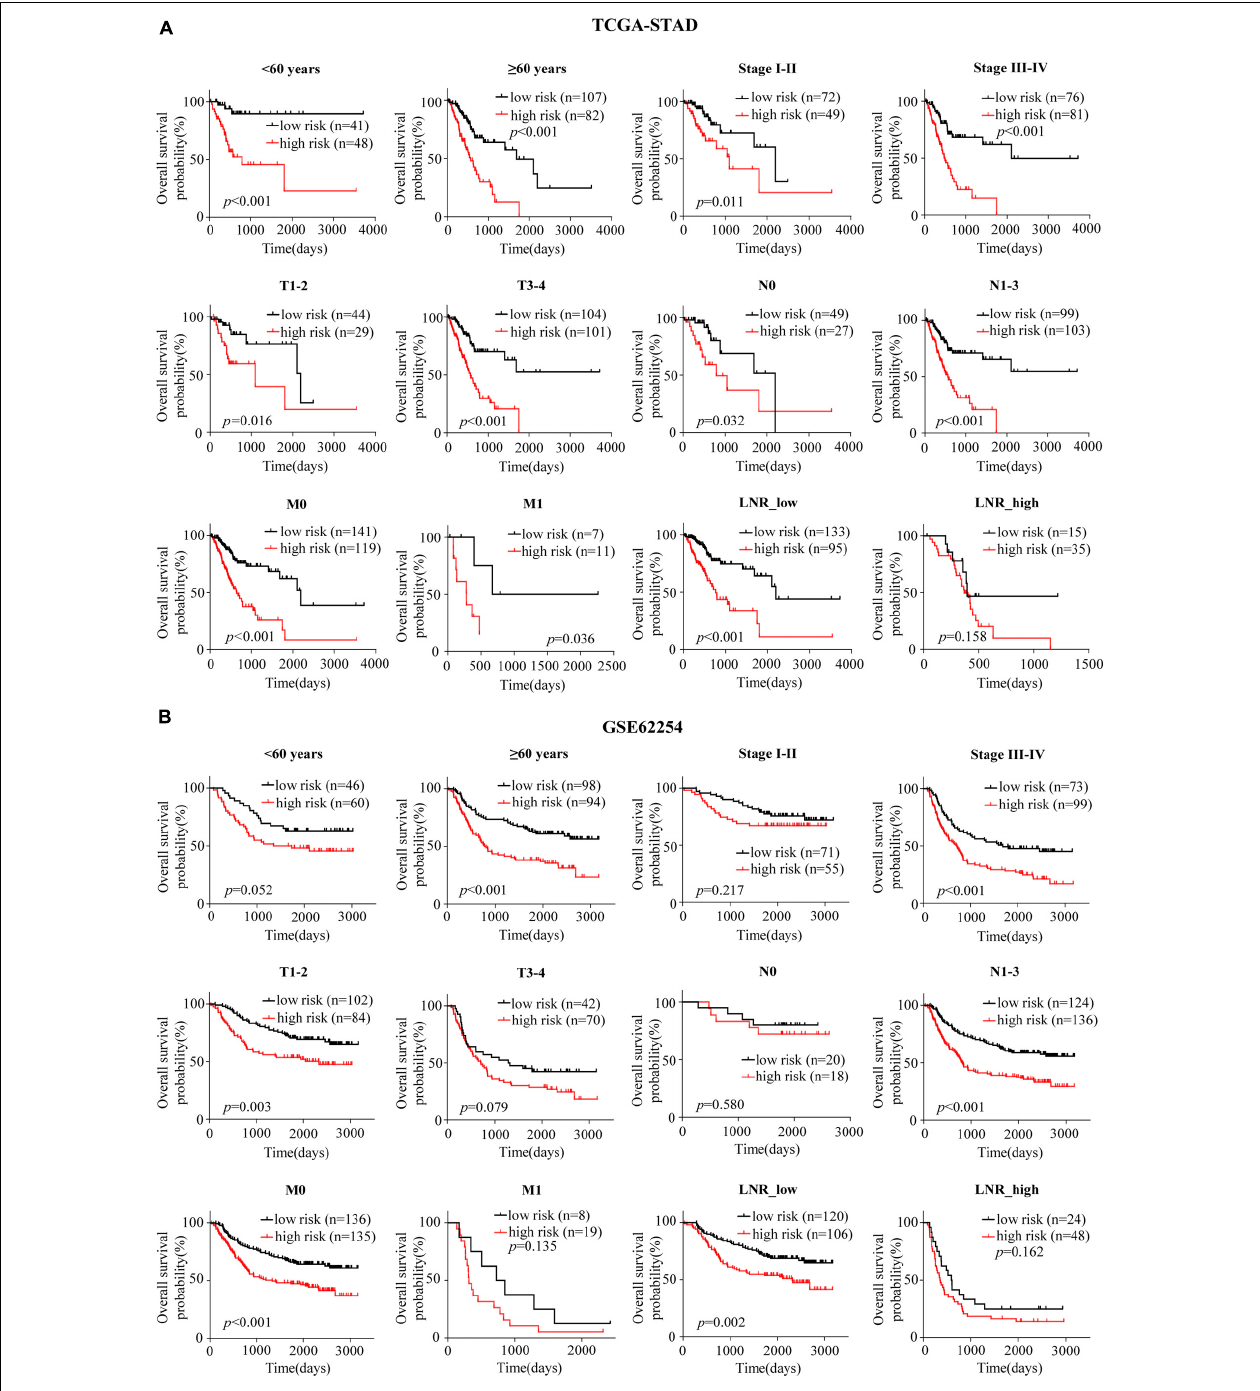
FIGURE 3 | Confirmation of the signature for OS prediction in different clinical subgroups. (A,B) Kaplan-Meier estimates of OS based on the EMT-related gene signature in subgroups stratified according to age, stage, T, N, M, and LNR in the TCGA-STAD (A) and the GSE62254 (B) cohorts.